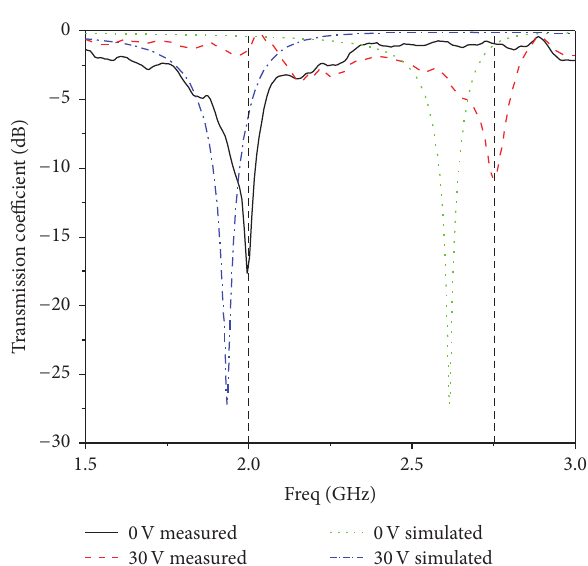
Figure 5: Simulated and measured transmission coefficients of the AFSS.